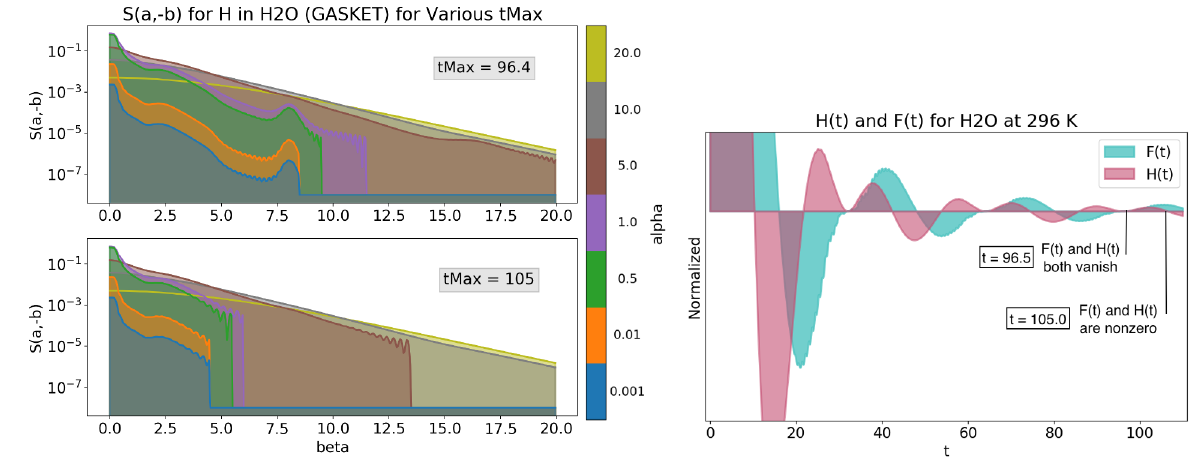
= 96 . 4 and the other max = 105 max